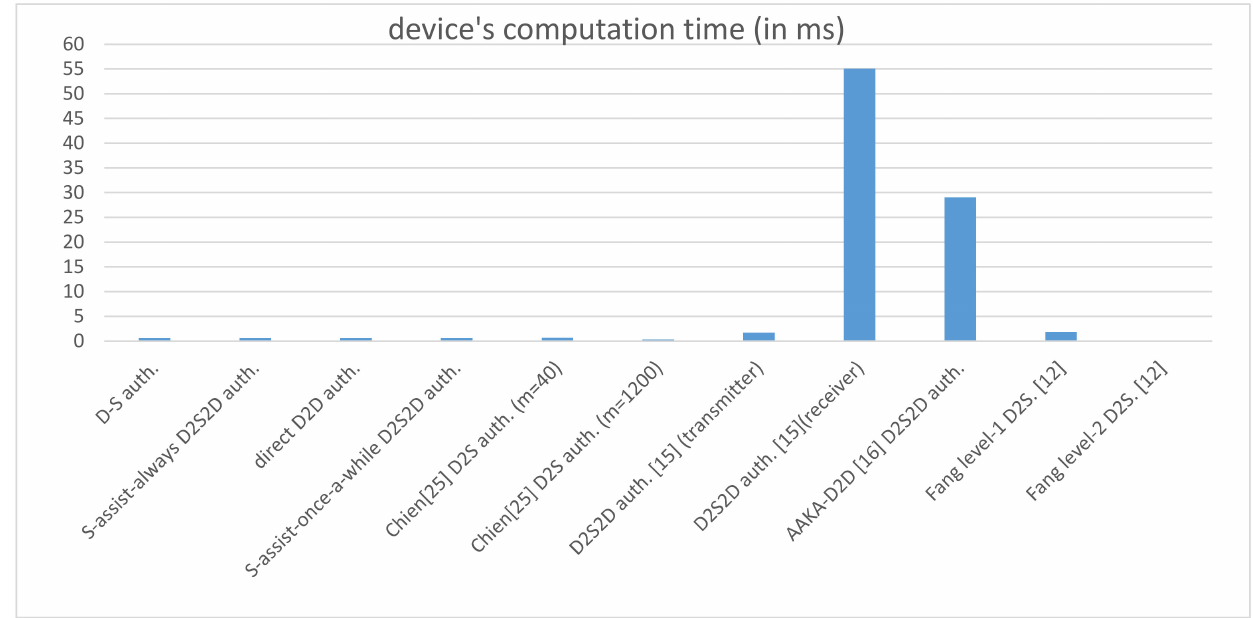
Figure 13. The estimated computation time of a device using the figures from Table